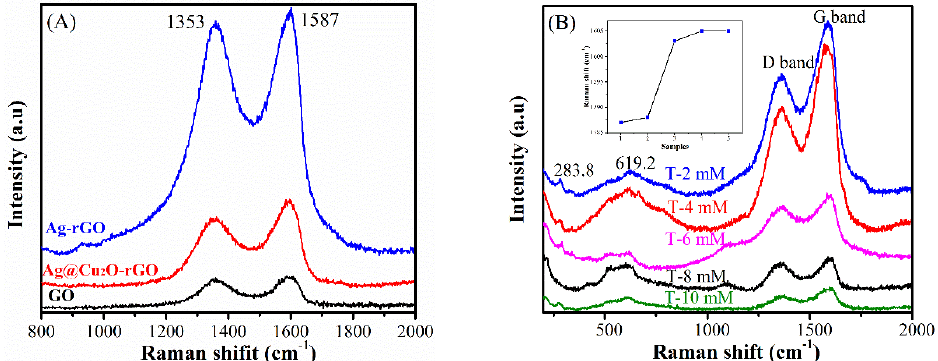
Figure 5. ( A ) Raman spectra of GO, Ag-rGO, and Ag@Cu 2 O-rGO; ( B ) Raman spectra of Ag@Cu 2 O-rGO nanocomposites for S-2 mM to S-10 mM, the inset shows the dependence of the intensity of Ag@Cu 2 O-rGO on Cu 2 O content.